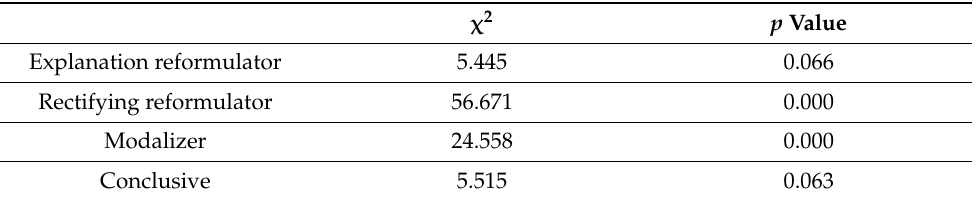
Table 5. Data from the Kruskal–Wallis ANOVA test on the functions of vamos and the education variable.